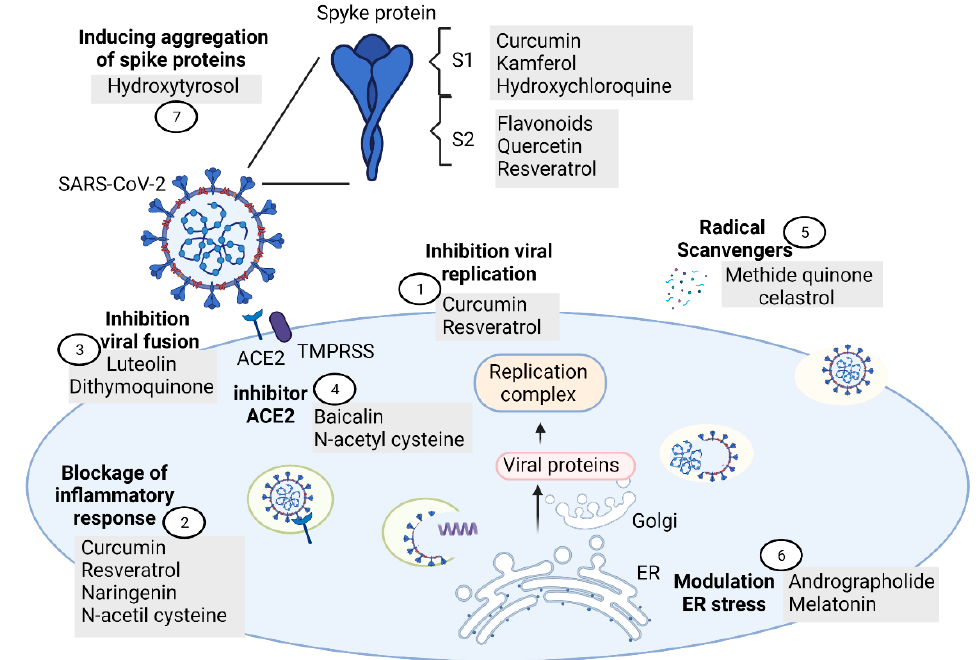
Figure 2. Mechanisms of antioxidant compounds that may possibly prevent and diminish neurological damage in patients with COVID-19. (1) Inhibition of the viral replication, (2) blockage of the inflammatory response, (3) inhibition of SARS-CoV-2 fusion/entry by interaction with SARS-CoV-2:ACE-2 interface, (4) inhibition of ACE2, (5) radical scavengers, (6) modulation of endoplasmic reticulum stress, and (7) inducing aggregation of SARS-CoV-2 spike proteins and disruption of the viral genoma.